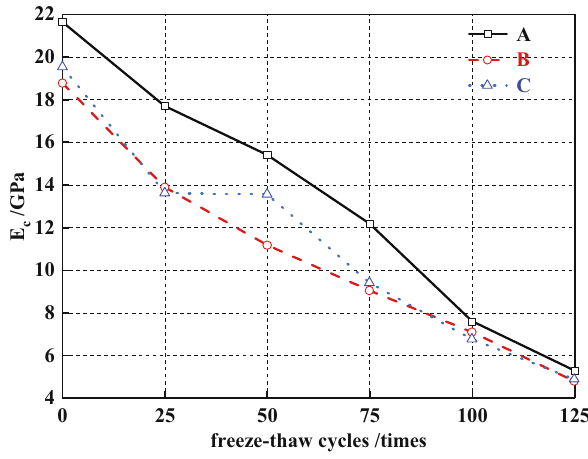
Figure 17: Relationship between E c and freeze – thaw cycles.